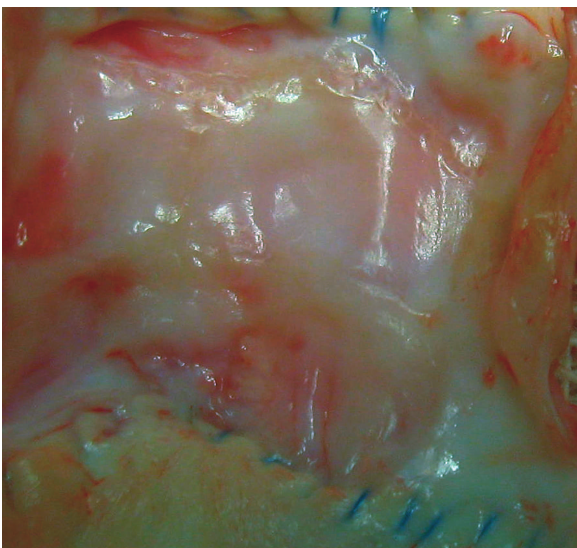
Fig. 3 - Aspecto macroscópico pós-explante. Aderência total das cúspides à parede do tubo (Grupo L-Hydro®)